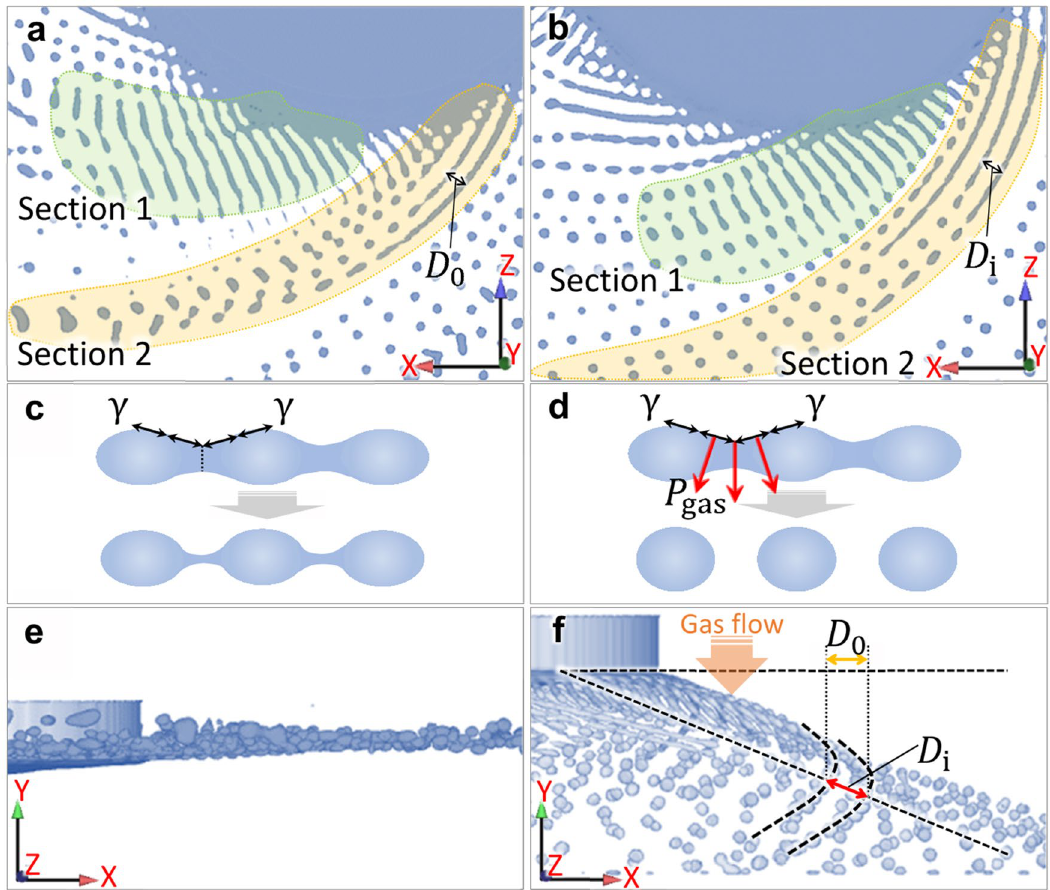
Figure 8. Granulation behavior in the simulation cases ( a , c , e ) without gas blast and ( b , d , f ) with disturbance effect. ( c , d ) Schematics show the dynamic pressure on the fluid surface exerted by the gas blast enhanced the fluid granulation. ( e , f ) Top views show that under the mechanical action of the gas flow, the distance between ligaments in the case with disturbance effect D i was larger than that in the case without gas blast D 0 .